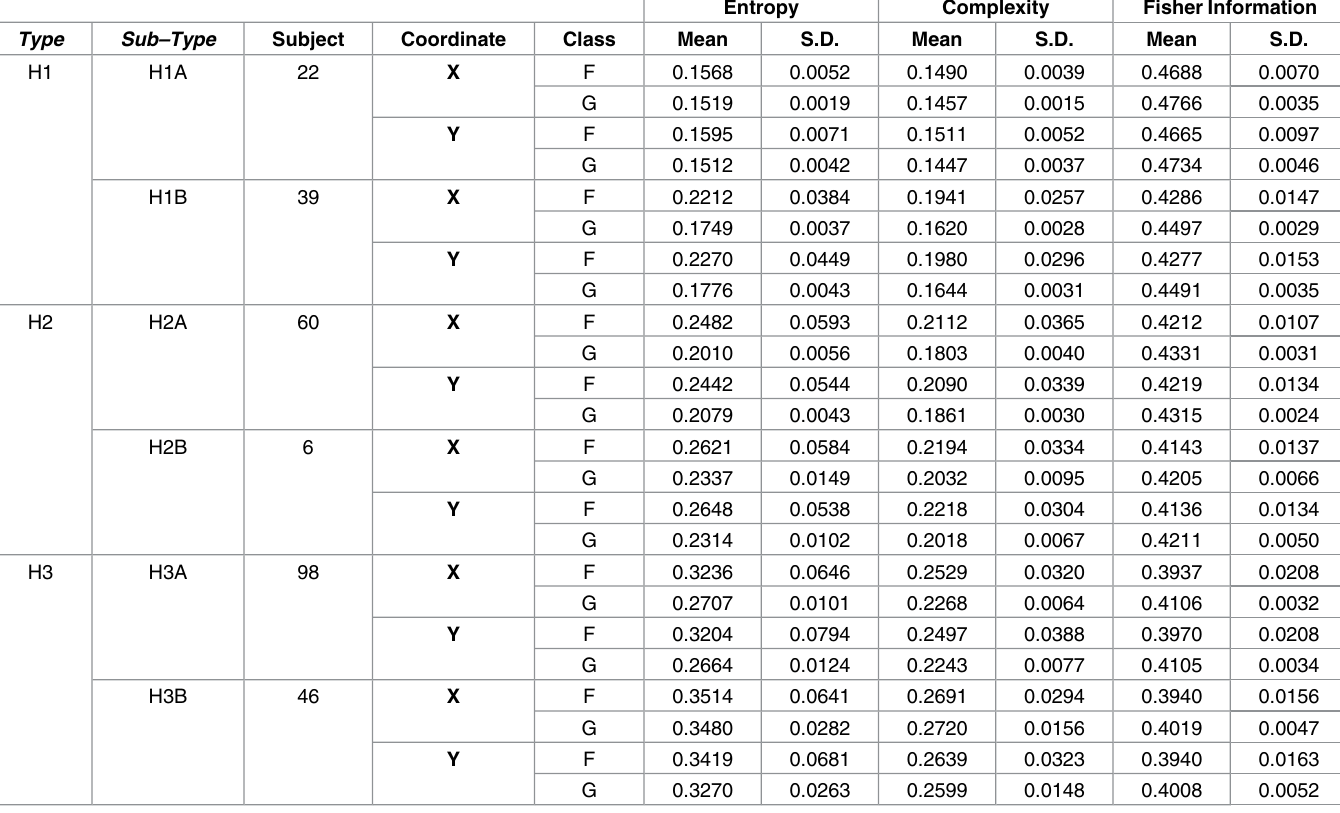
Table 1. Sample mean and standard deviation (S.D.) of the time series quantifiers for the 25 genuine (G) and 25 skilled forged (F) signatures, for each of the typical subjects: H1A, H1B, H2A, H2B, H3A, and H3B (same order as in Fig